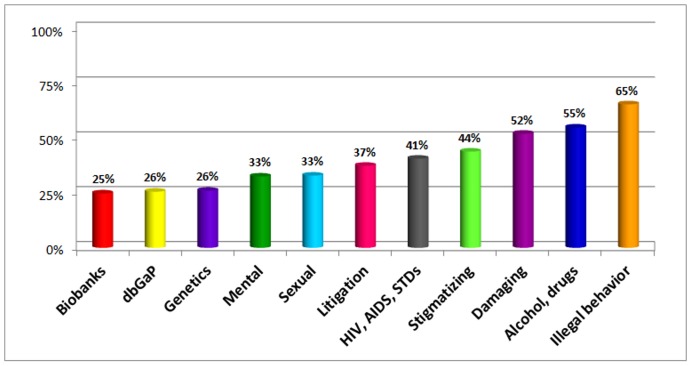
“For which of the following research activities would your IRB typically require or recommend that the investigator apply for a Certificate?”.*Survey respondents were instructed to “Assume in each case that identifiable data will be collected.”. Key: Biobanks: Studies that collect and store biospecimens and associated data for future research use. dbGaP: Research involving depositing data in centralized repositories for widespread sharing (e.g., placing data from genome-wide association studies into NIH's Database of Genotypes & Phenotypes (dbGaP). Genetics: Genetic research. Mental: Research on participants' psychological wellbeing or mental health. Sexual: Research on participants' sexual attitudes, preferences, or practices. Litigation: Research where the topic under study could be the subject of litigation (e.g., breast implants, environmental or occupational exposures). HIV/AIDS/STDS: Research on HIV, AIDS, or other STDs. Stigmatizing: Research involving information that might lead to social stigmatization or discrimination. Damaging: Research that gathers information that could be damaging to a participant's financial standing, employability, or reputation. Alcohol, drugs: Research on the use of alcohol, drugs, or other addictive products. Illegal: Research that collects information on illegal conduct.